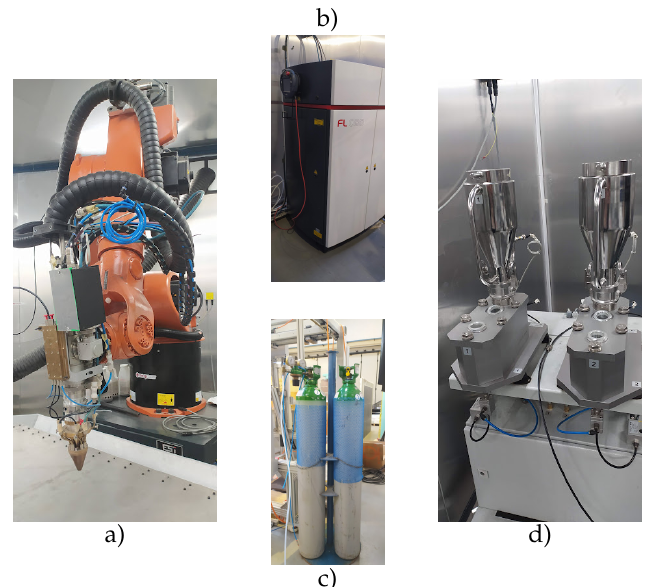
Figure 3. DLD system used for the performed depositions: ( a ) shows the Kuka 6-axis robotic arm mounted with the powder nozzle, powder splitter, and E-MAqS temperature control system; ( b ) shows the fibre laser; ( c ) the argon cannisters that fuel the shielding and powder carrying gas, while ( d ) shows the disk powder feeders containing the used